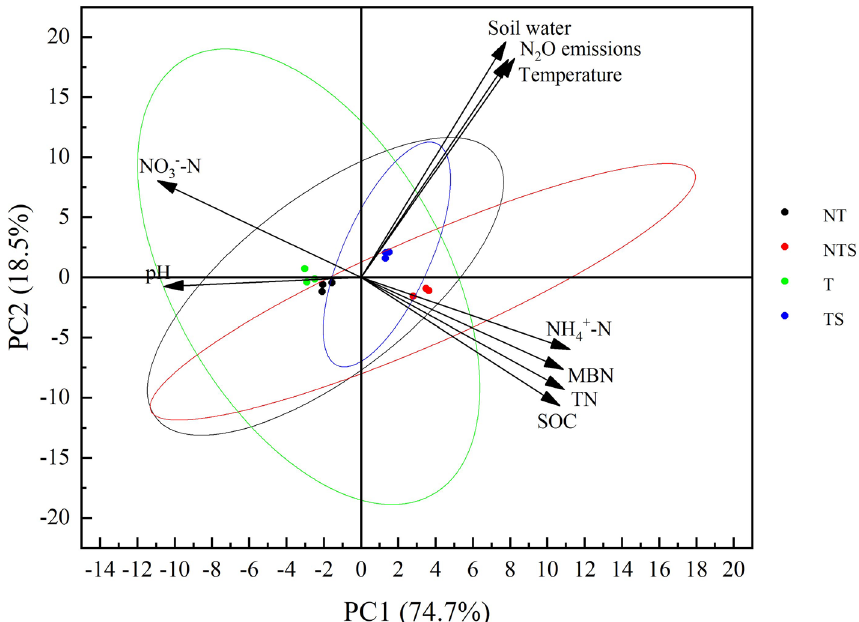
Figure 6. Principal component analysis of N 2 O emission and physical and chemical properties of soil.